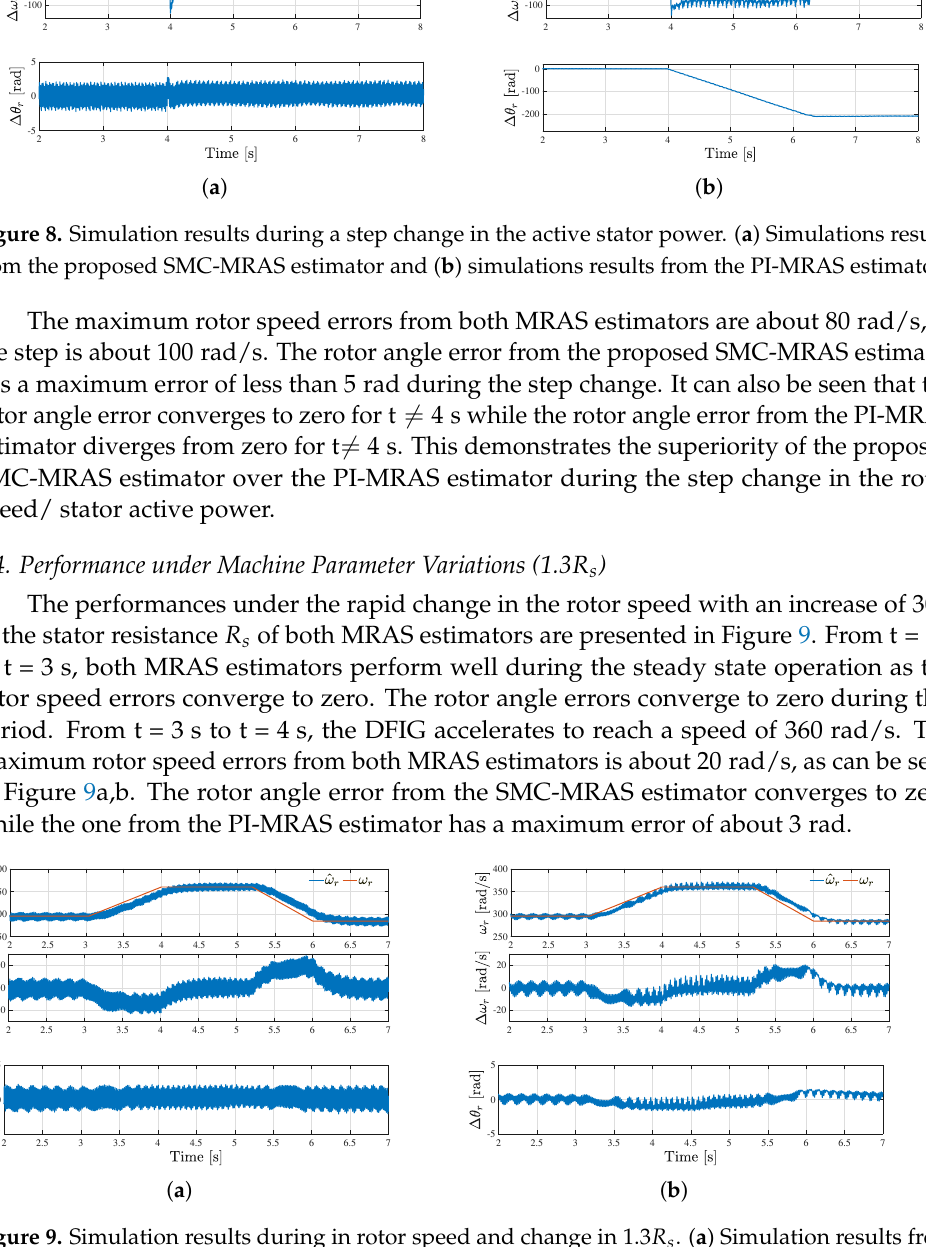
Figure 9. Simulation results during in rotor speed and change in 1.3 R s . ( a ) Simulation results from the proposed SMC-MRAS estimator and ( b ) simulation results from the PI-MRAS